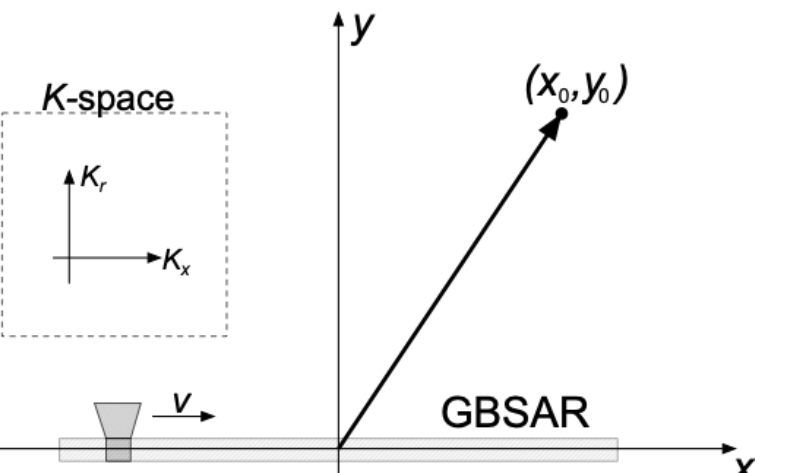
Figure 1. Ground-based SAR geometry. Coordinates ( x 0 , y 0 ) represent position of a point object in real space. In the dashed square, coordinates of the Fourier domain space or K -space are presented. K r is a wave vector coordinate in the range direction while K x is a wave vector coordinate in the x